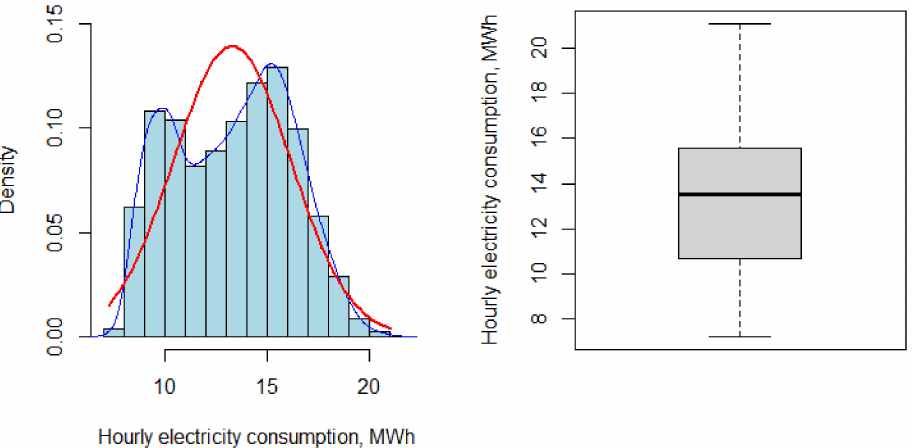
Figure 8. Graphical representation of the distribution of hourly electricity consumption for the M1 object. Source: own study in the RStudio environment.